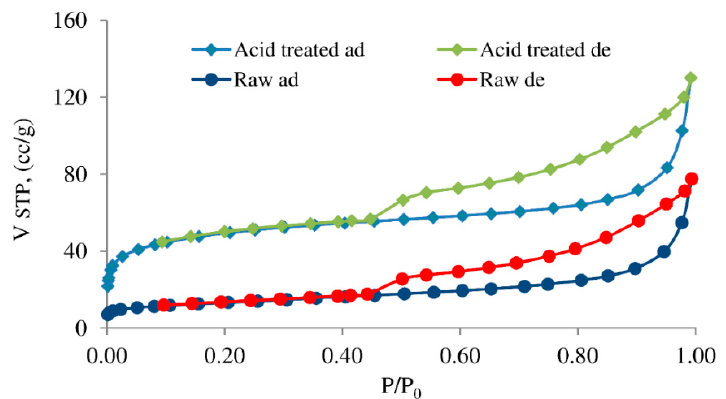
Figure 6. Nitrogen adsorption/desorption isotherms for saponite samples.